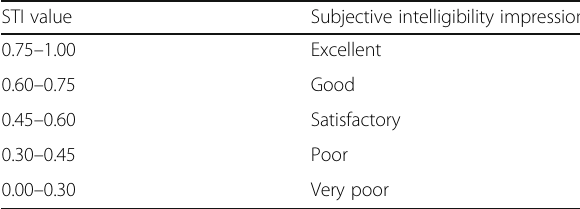
Table 2 Evaluation standards of STI values according to ICE 60268-16 STI value